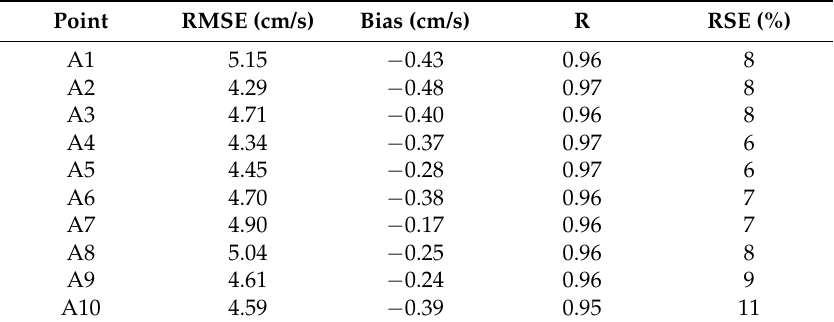
Table 6. Statistics of u velocity component forecasts (Model U8, 1 h forecast window).